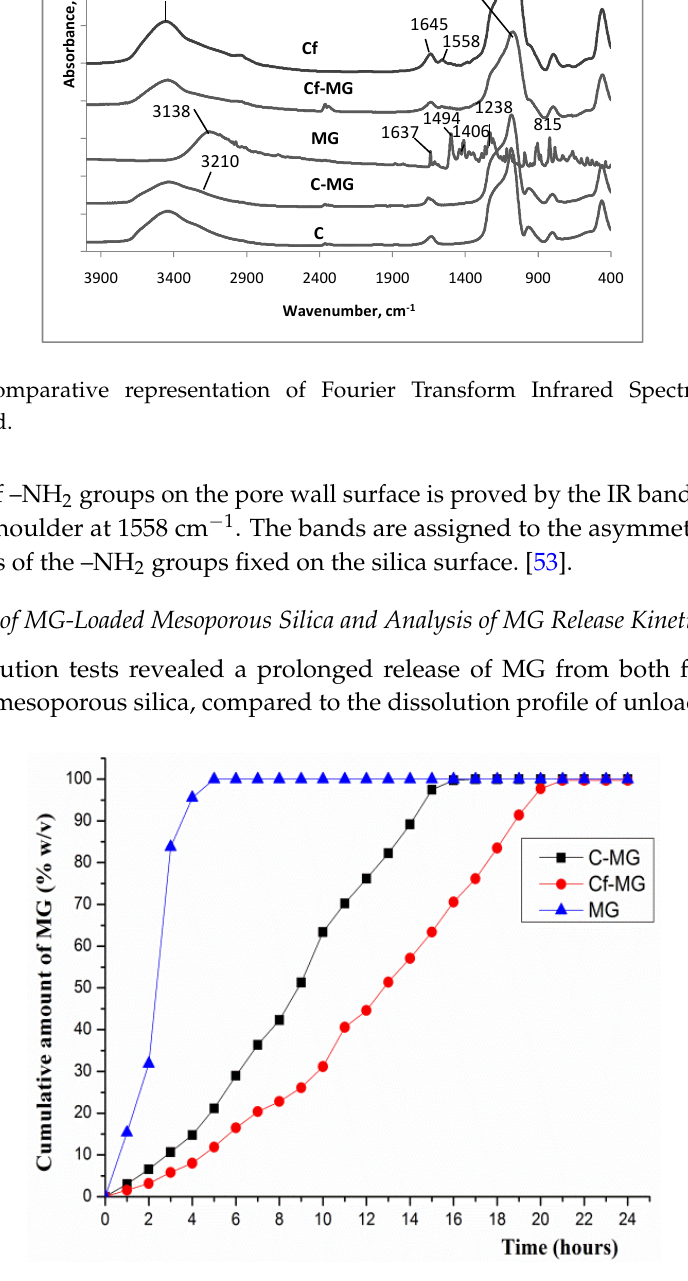
7 of 12 Figure 2. SEM images for: ( a ) pure SBA ‐ 15 silica (C); ( b ) functionalized SBA ‐ 15 silica with APTES (Cf);